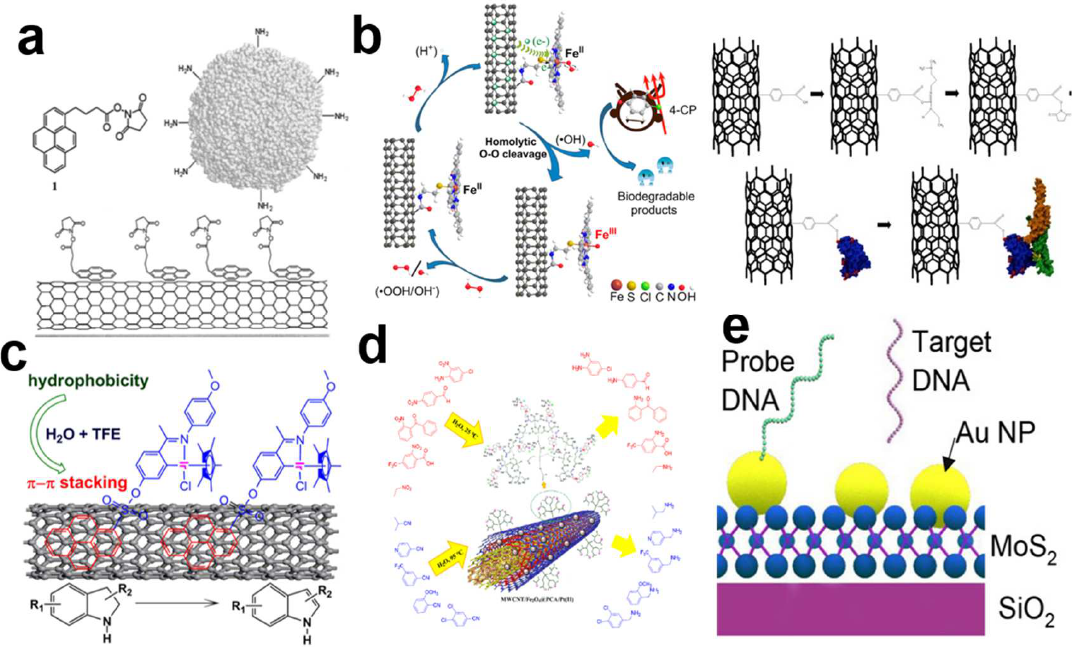
Figure 7. Functionalization of carbon nanotubes (CNTs). ( a ) Noncovalent modifications can be used to anchor molecules around nanotubes [102]. (Copyright © 2001, Journal of the American Chemical Society.) ( b ) The introduction of the -COOH group and –COOH to the surface of the CNT by the